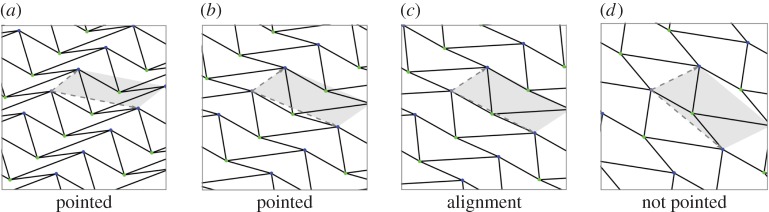
(a,b) Two snapshots of the unique, expansive trajectory of a periodic pseudo-triangulation. When the mechanism ceases to be pointed through the alignment of edges (c), both the expansive and the auxetic behaviour disappear. (d) In this configuration, the lattice generators have opposite growth behaviour: an increase along one axis leads to a decrease along the other axis. (Online version in colour.)